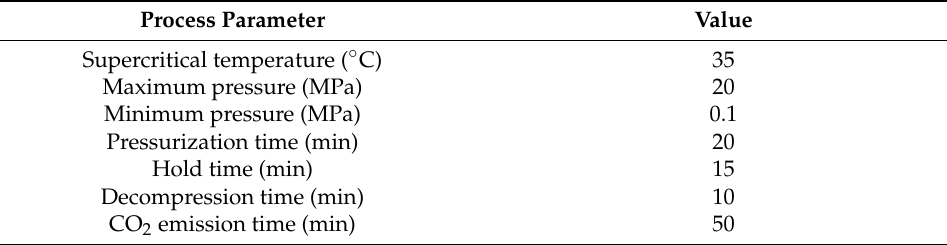
Table 1. Process parameters for ScCO 2 dewatering. Process